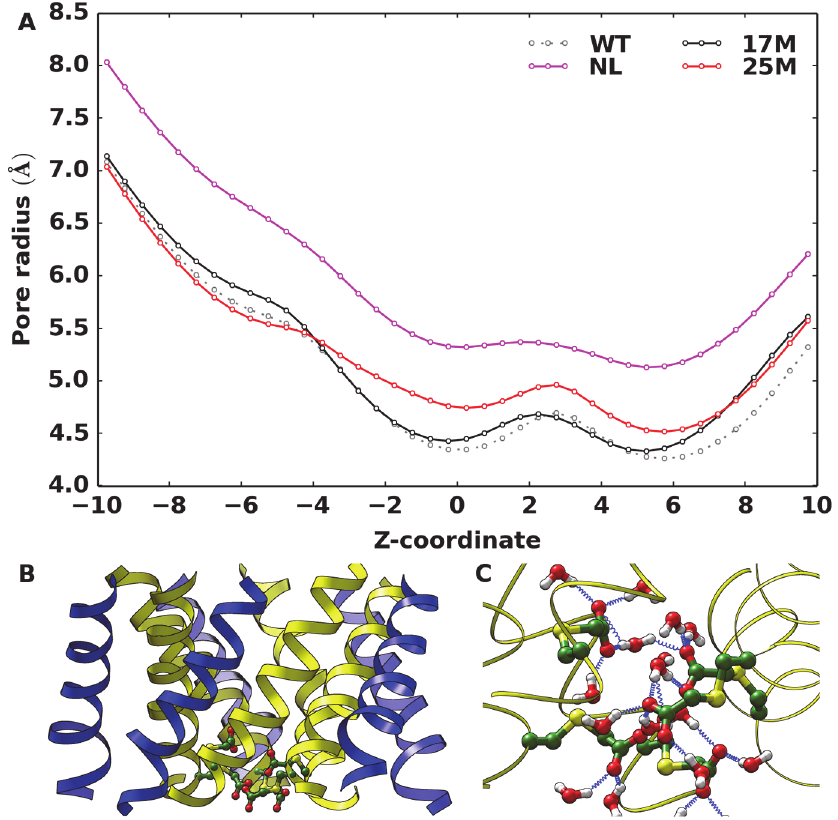
Fig 5. Average pore radius and protein-water interaction at cytoplasmic entrance. (A) Average pore radius along the axial position. (B) Representative snapshot of the 17M model with charged groups shown in green. (C) Interaction of charged groups with water molecules within a distance of 3 Ang (17M model). Protein-water hydrogen bonds are shown as blue